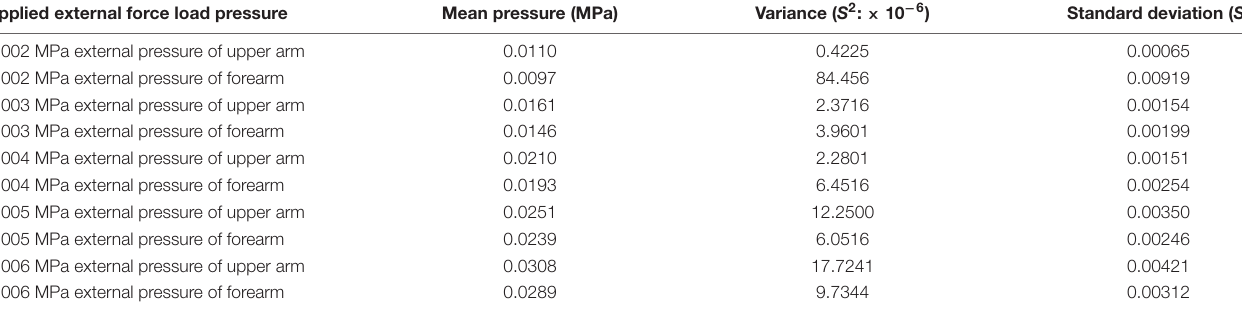
TABLE 6 | Eight-point-specific pressure table of lymph and blood layers of the upper limb model with different external force pressure values. Applied external force load pressure